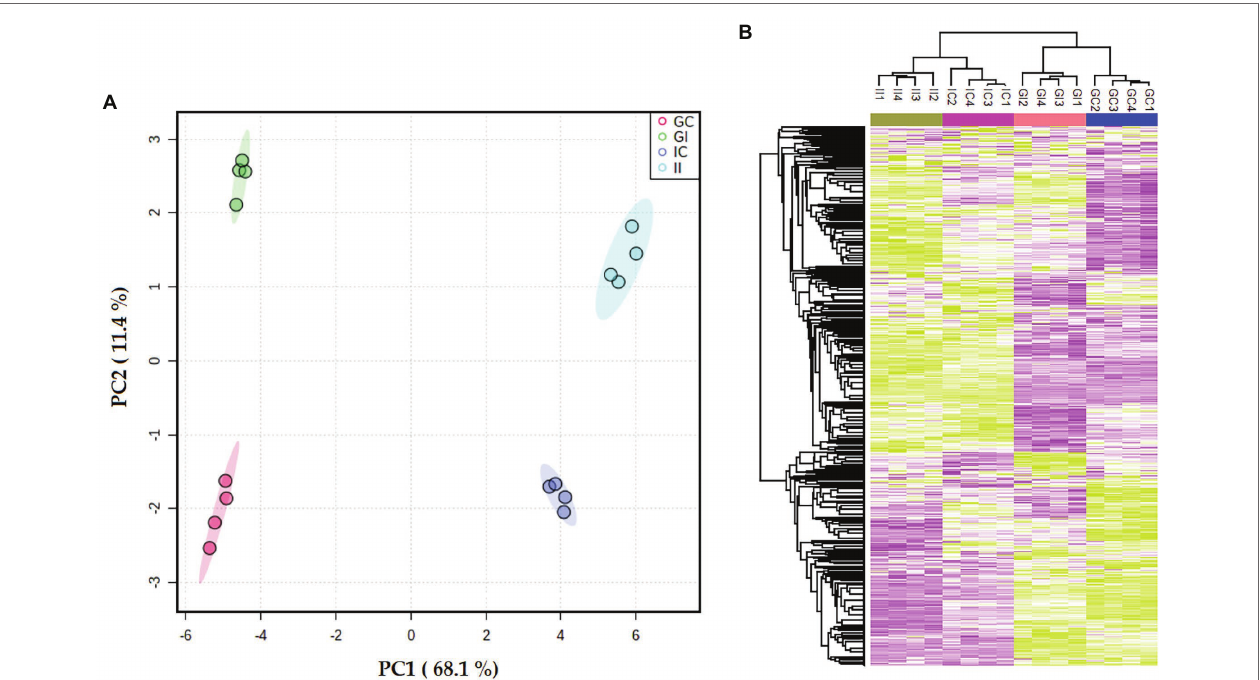
FIGURE 2 | (A) Principal component analysis (PCA) differentiated the potato leaf proteomes of potato plants (Gladiator and Iwa) with roots non-inoculated and inoculated by Spongospora subterranea . (B) The Z-scored abundance of the complete set of identified proteins. GI, Gladiator infected; GC, Gladiator control; II, Iwa infected; and IC, Iwa